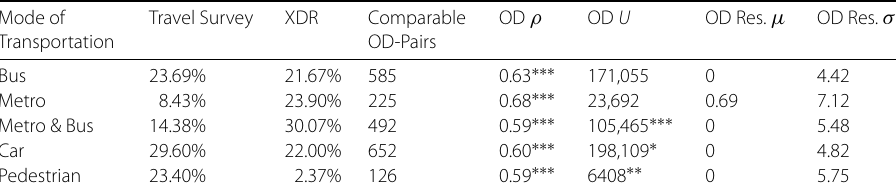
Table 1 Summary results from our proposed pipeline. Each row is a modal cluster or choice of one or more modes of transportation for commuting trips. The Travel Survey column shows the distribution of these modes according to collected data in 2012. The XDR column shows the inferred distribution used our methods. Since the Travel Survey does not contain trips in all possible Origin-Destination (OD) pairs, the third column shows the number of comparable pairs for evaluation. We compared the Spearman rank-correlation coefficient ρ for each modal cluster to evaluate coherence between inferred and known commuting flows, and performed the Mann–Whitney U test to measure whether both distributions were the same. Results indicate a high level of similarity but statistically different distributions. Legend: ∗ : p < 0.05; ∗∗ : p < 0.01; ∗∗∗ : p < 0.001 Mode of Travel Survey XDR Comparable OD ρ OD U OD Res. μ OD Res. σ Transportation OD-Pairs